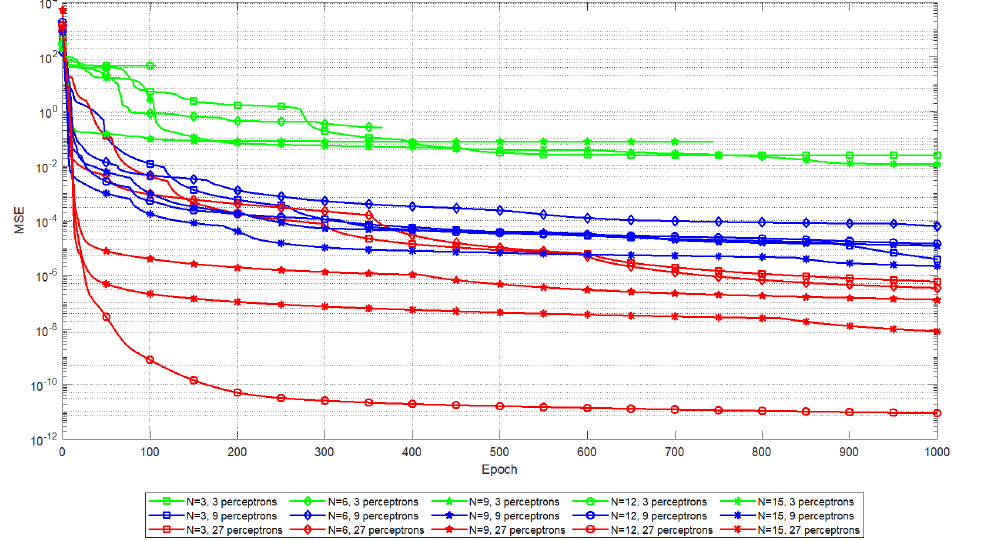
Figure 6. Training Performance considering 3, 9, and 27 perceptrons per layer, for N = 3,6,9,12, and 15 Sensors (DFNN Network).